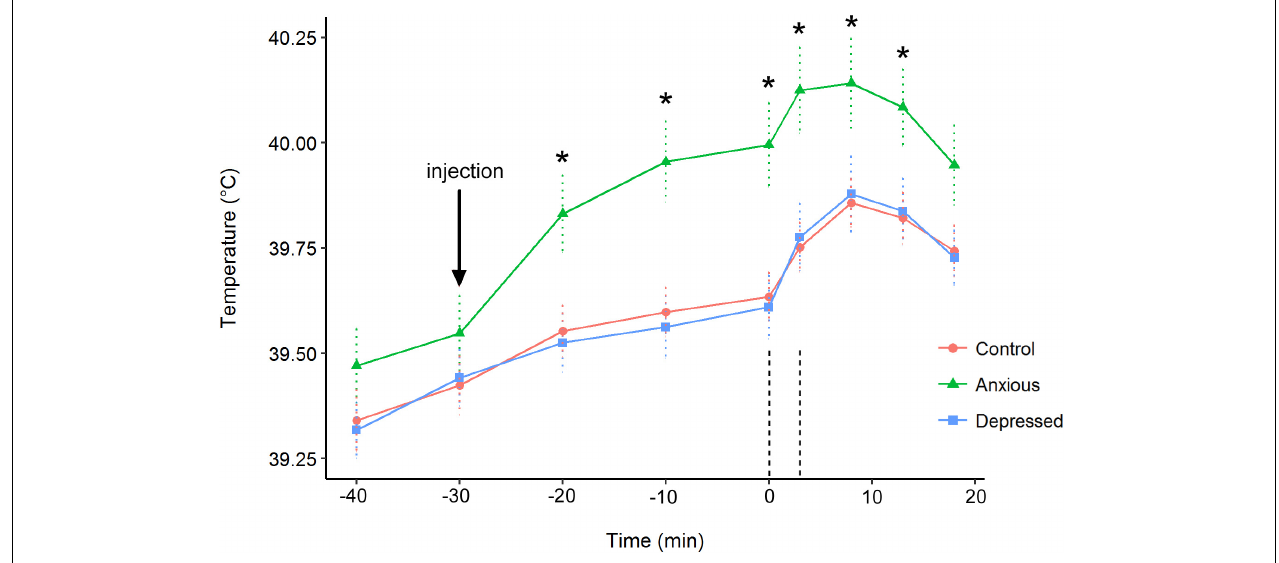
FIGURE 5 | Mean ( ± SE) body temperatures for the Control ( • ), Depressed ( (cid:4) ), and Anxious ( (cid:78) ) groups. The arrow denotes the time of injection prior to testing. The vertical dashed lines indicate the beginning and end of attention bias testing. The “ ∗ ” symbol denotes a significant difference between the Anxious group mean and the other groups as determined using a repeated measures linear mixed model.